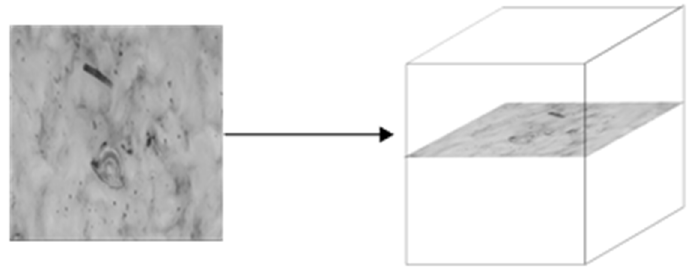
Figure 16. Schematic diagram of image information expansion.